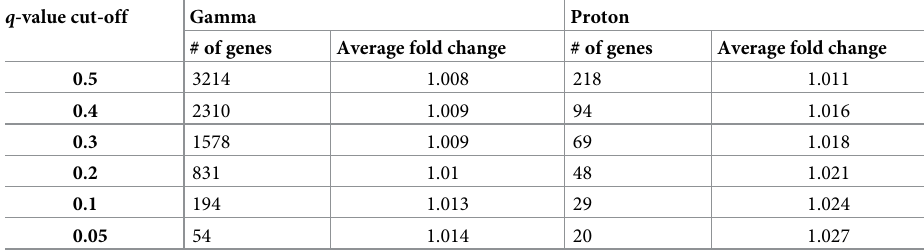
Table 1. Number of dose-responsive genes at different q -value cut-offs. q -value cut-off